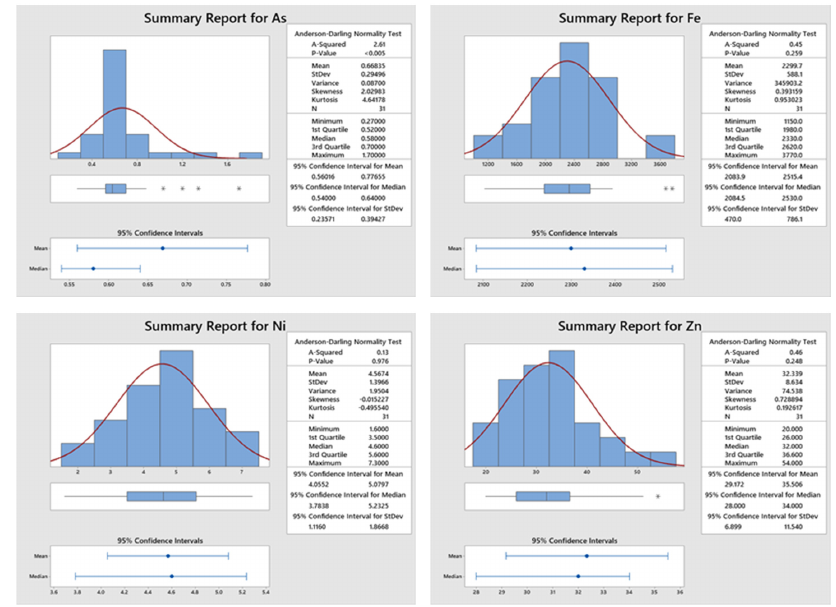
Figure 3. Summary Report for As and some selected elements created byMinitab ® 19.